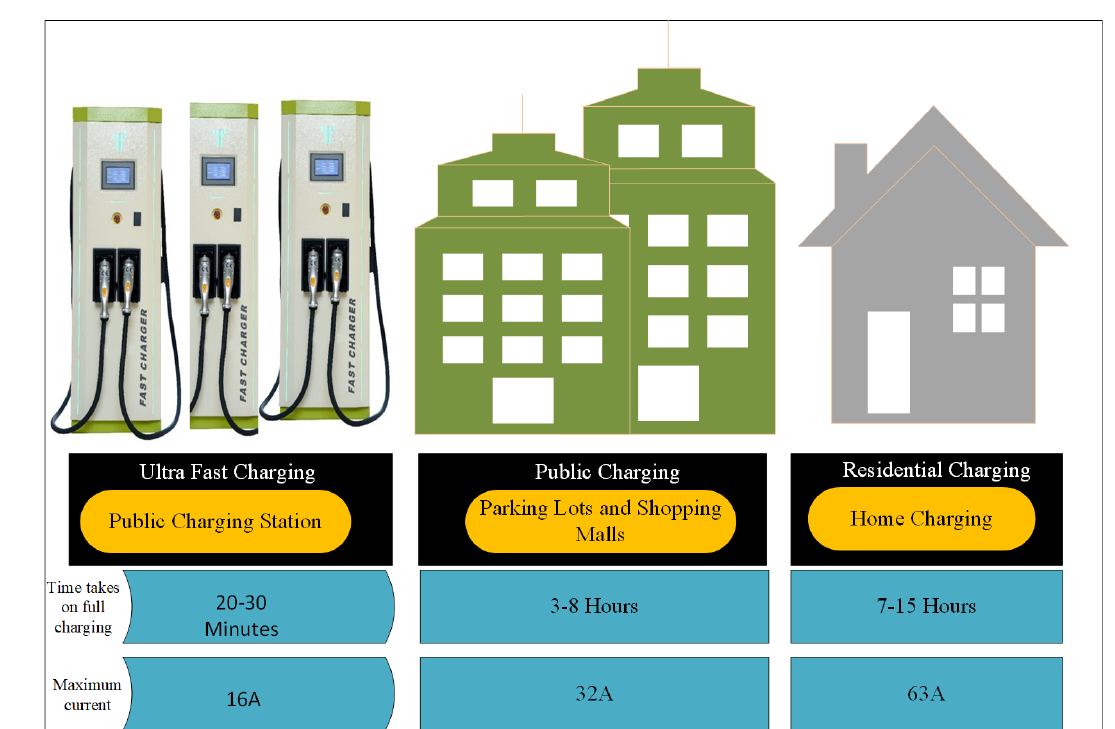
Figure 8. Charging Technologies and its